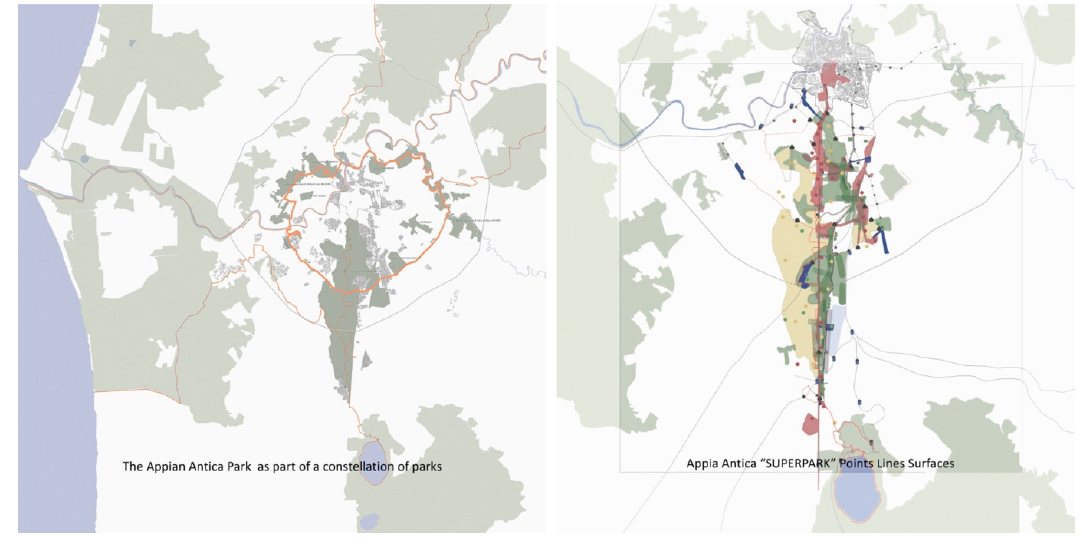
Figure 3. Left : the Appian Antica Park as part of a constellation of parks; right : Appia Antica ‘SUPERPARK Points Lines Surfaces’ (Source: authors)